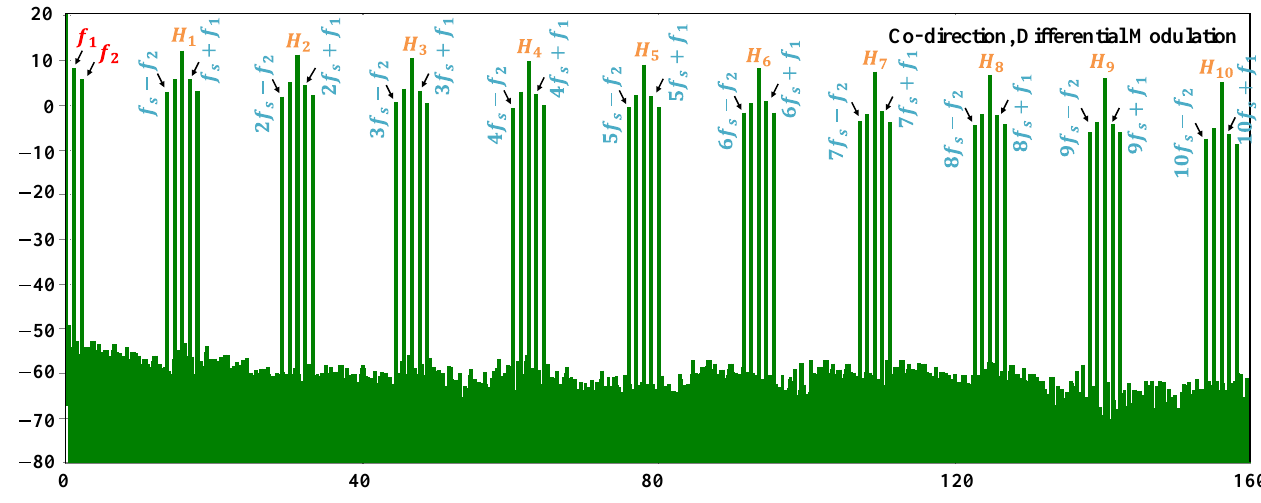
Figure 8. Electrical spectrum of the up-converted signal, which represents the electrical power in dBm as a function of frequency in GHz, at 𝑛𝑓 𝑠 ± 𝑓 𝑚 at the SOA-MZI output for the differential